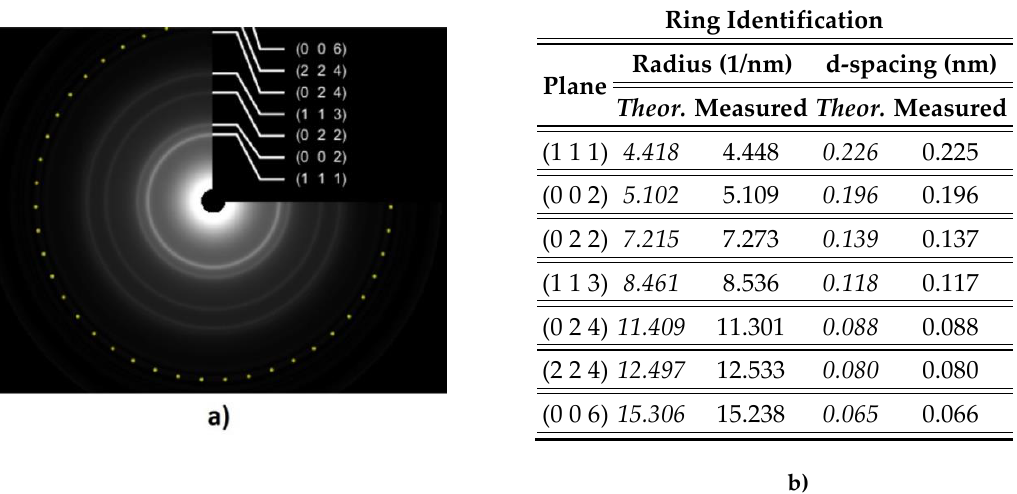
b) Figure 11. SAED investigation for PtTi/Si thin films: ( a ) Indexed SAED patterns of PtTi/Si. Inset shows Miller indices for FCC Pt tetragonal Ti α and tetragonal TiO 2 – anatase; ( b ) Electron diffraction data.